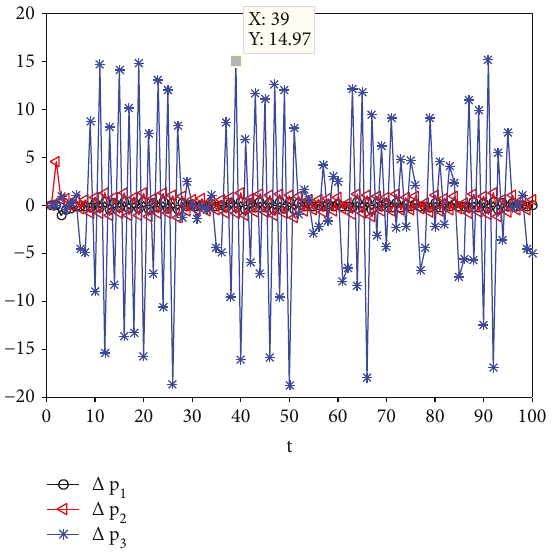
, p , p = 18 52, 1 2 3